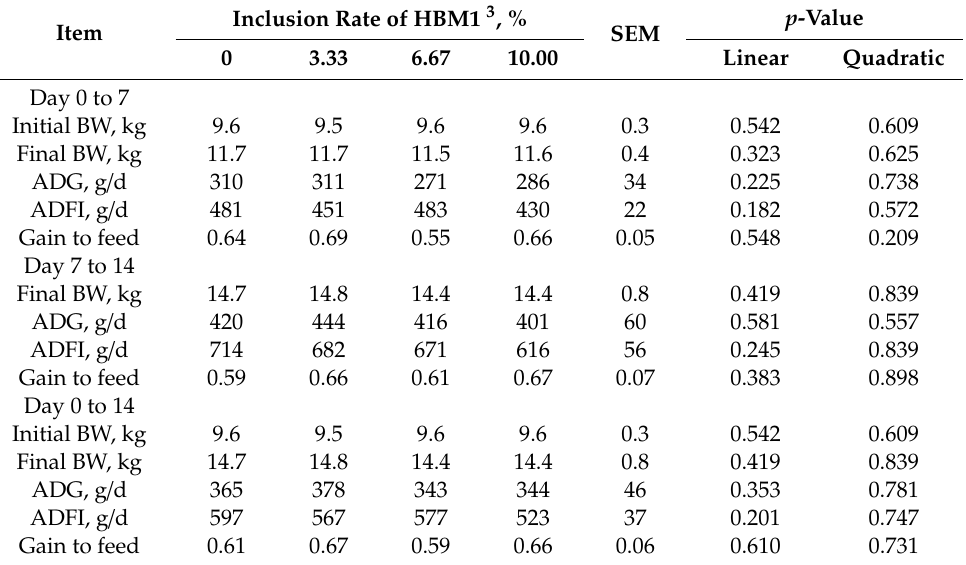
Table 4. E ff ects of hatchery byproduct mixture (HBM)1 on growth performance of pigs 1,2